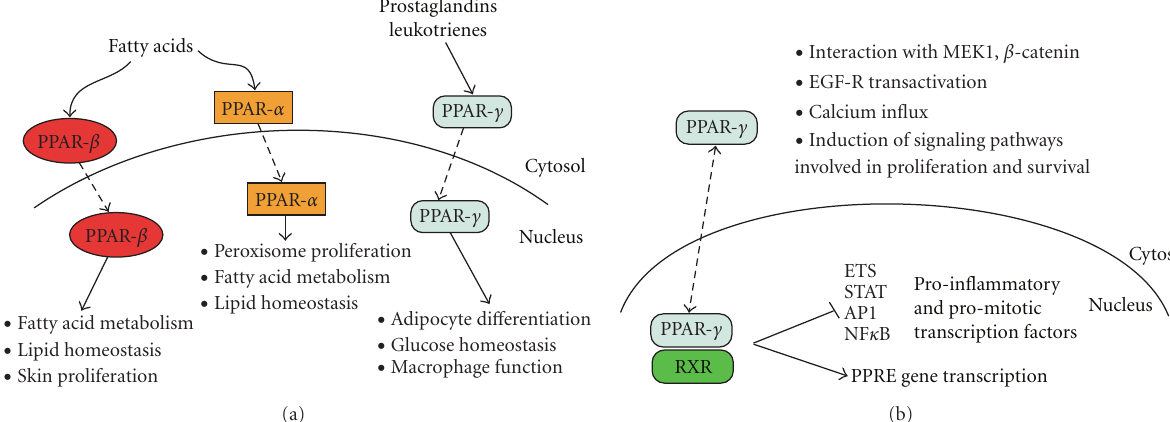
Figure 2: Components and signaling pathways of the PPAR system. (a) Schematic representation of components of the PPAR system. PPARs act as ligand-activated transcription factors that are responsive to the lipid status of the cell. The physiological ligands for these nuclear receptors are typically unsaturated fatty acids (FFAs) and their eicosanoid products. PPARs regulate the expression of genes that encode proteins involved with lipid metabolism (oxidation), leukotriene degradation, energy balance, eicosanoid signaling, cell di ff erentiation and tumorigenesis. PPARs are di ff erentially expressed in the various tissues. PPAR- α is highly expressed in liver, kidney, heart, brown adipose tissue, and the intestine, whereas PPAR- γ is found in adipose tissue, small intestine, and lymphatic tissues. PPAR- β is ubiquitous. (b) PPAR- γ genomic versus nongenomic actions . PPAR- γ belongs to the class of nuclear receptors, with a typical modular structure composed by at least an N-terminal transactivation domain and a DNA binding domain (DBD). Upon ligand binding, a conformational change leads to the release of corepressors (NCoRs), recruitment of coactivators (NCoAs), heterodimerization and transactivation of PPRE-related promoters. This genomic function of PPAR- γ controls immune response, as well as lipid and glucose metabolism. Nuclear PPAR- γ exerts also a negative cross-talk towards major proinflammatory and promitotic transcription factors. Cytoplasmic PPAR- γ , by interacting with proteins (MEK1, β -catenin) and activating transmembrane proteinases, elicits rapid and transient nongenomic e ff ects that modulate EGF-R transactivation, calcium influx, and PI3K/Akt, IKK/NF κ B and MAPKs signaling pathways.